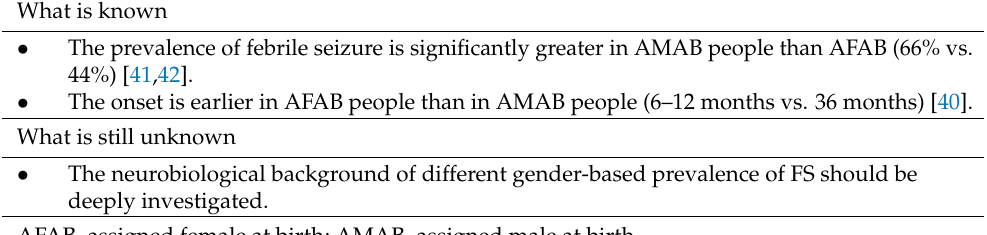
Table 1. Available evidence on the relationship between febrile seizures (FS) and gender.